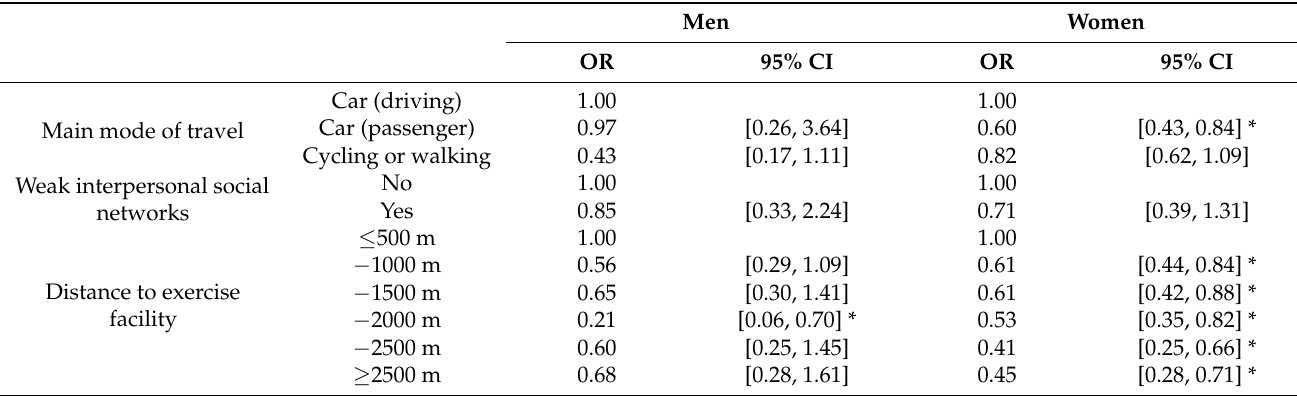
Table 3. Associations between participation in the square-stepping exercise, interpersonal social networks, and distance to exercise